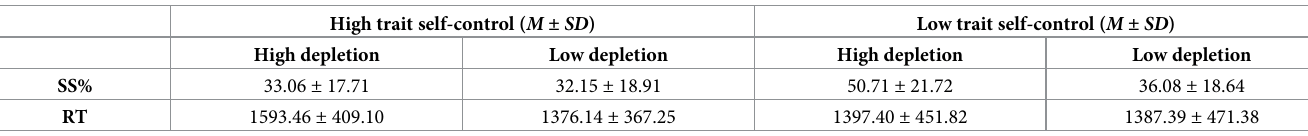
Table 7. Descriptive statistics of SS% and RT during the intertemporal choice